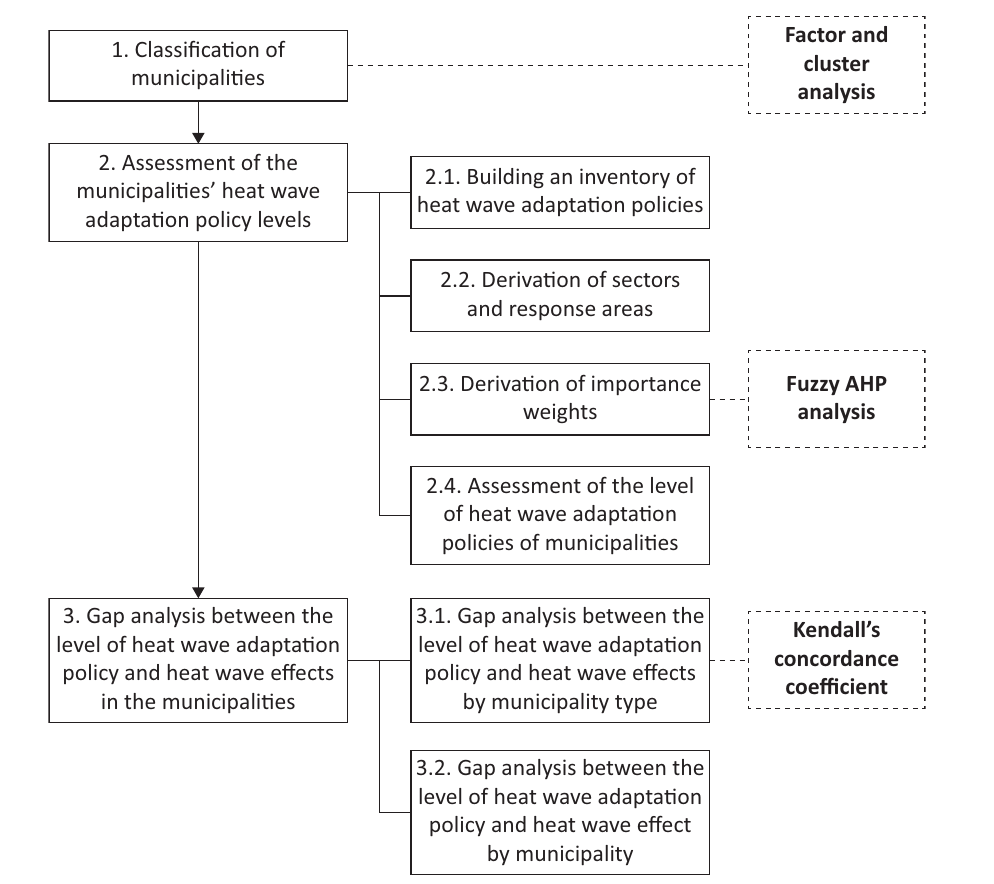
Figure 1. The flow of this